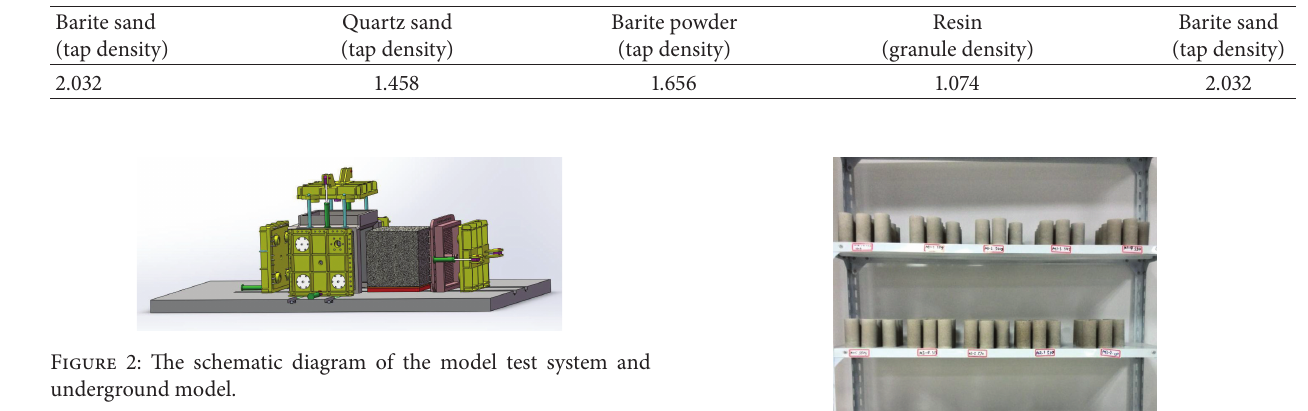
Table 1: Bulk density of raw material (g/cm 3 ).